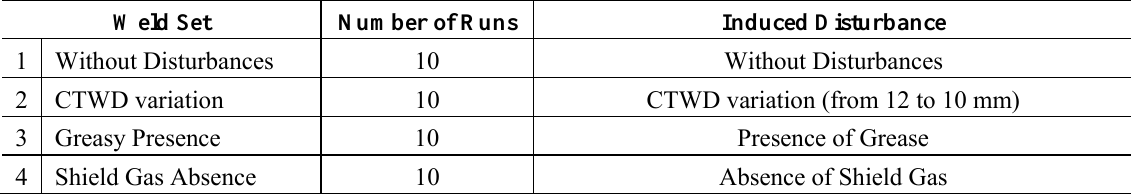
Table 2. Welding Experimental